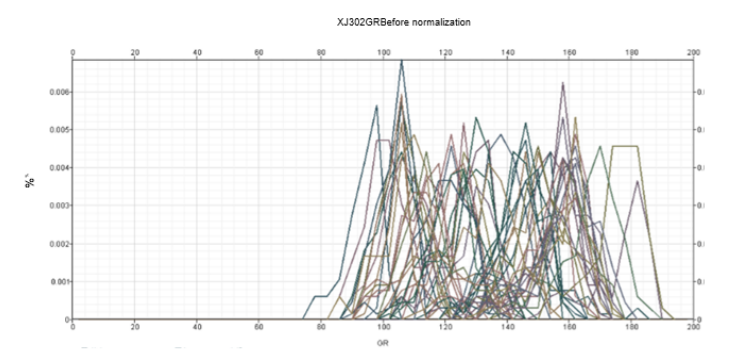
Fig. 8 Distribution of GR curve of standard layer before